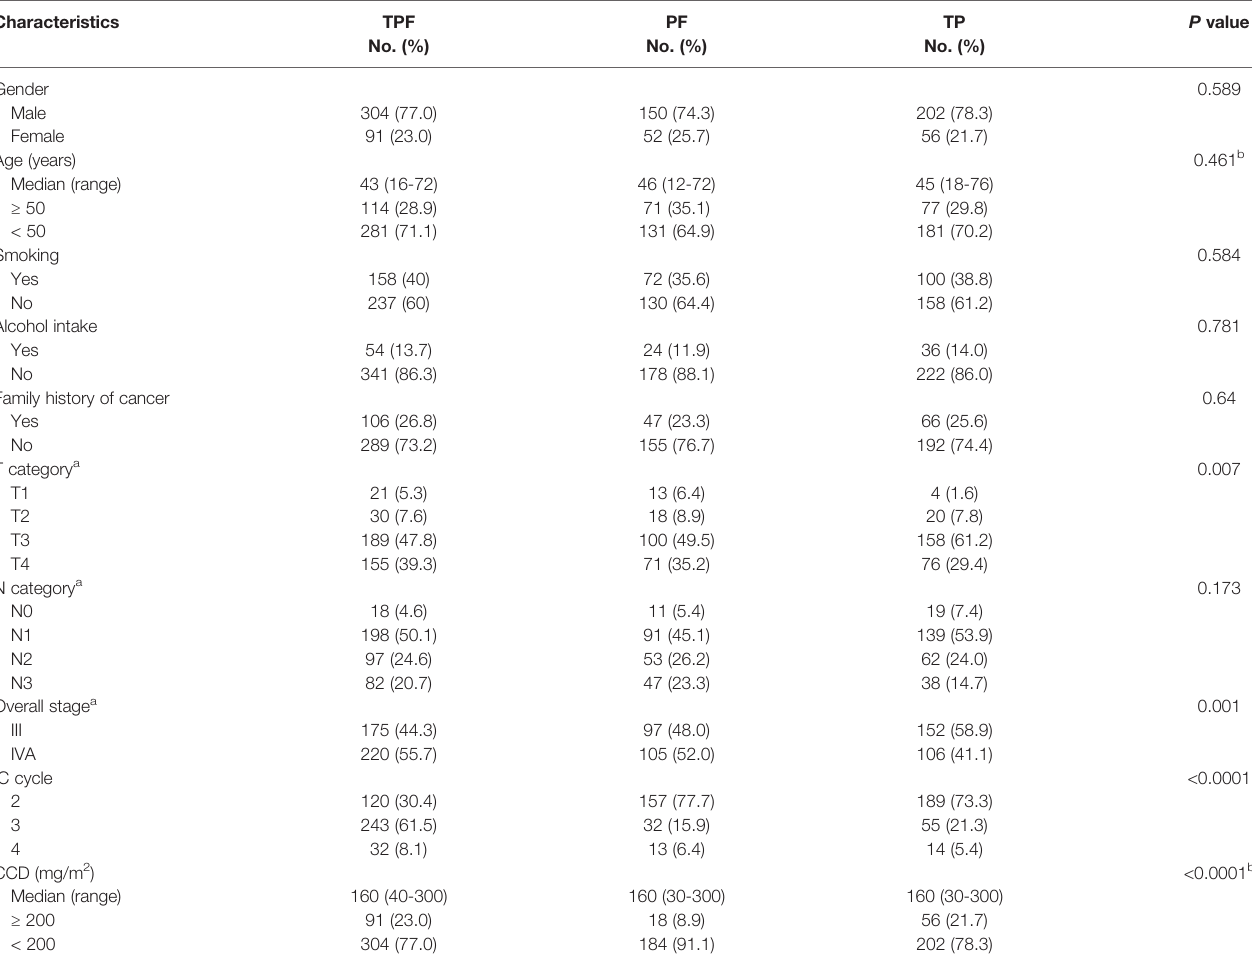
TABLE 1 | Baseline information of 855 patients receiving different IC regimens.